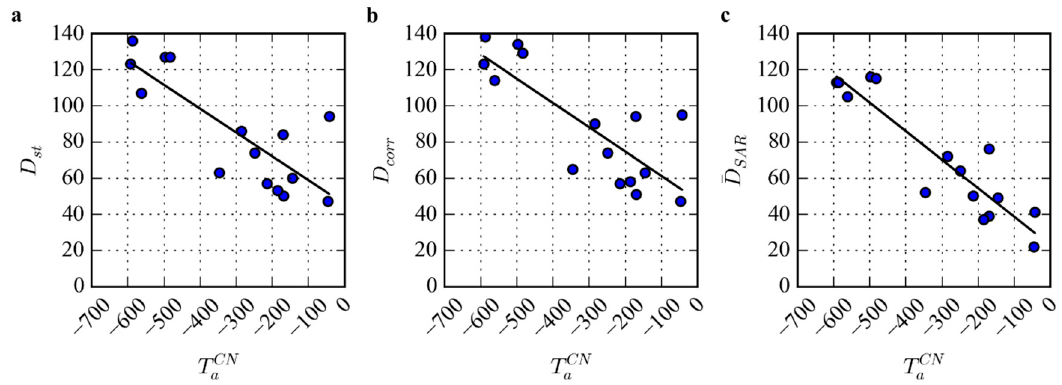
Figure 17. Scatterplots of the cumulative negative air temperature compared to the ice season duration (ISD) obtained from the coastal observations ( a ), maximum ( b ) and spatial-mean ( c ) ISD from the satellite data.